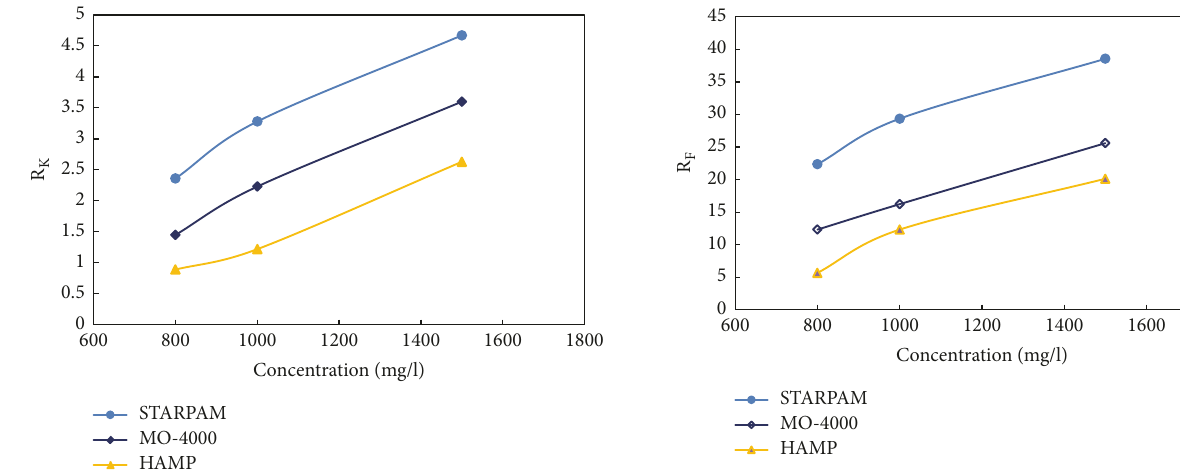
Figure 9: Resistance coefficient of three polymers.